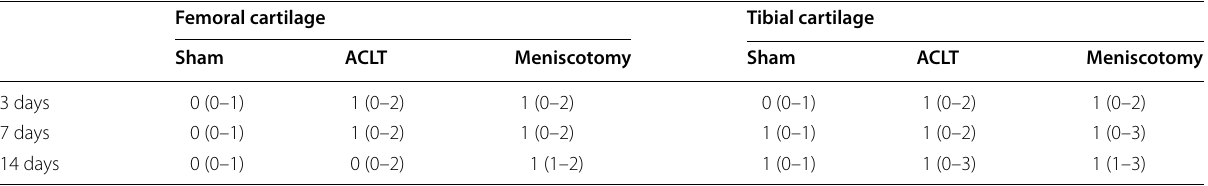
Three groups of mice were subjected to a sham procedure, transection of both the knee collateral and anterior cruciate ligaments (ACLT) or ACLT followed by transection of the medial meniscus (MNCT) and sacrificed at various days postsurgery. Structural damage of the cartlage in the distal femur and tibial plateau was evaluated using OM, according to previous criteria (see text for details). Data represent medians (range) of n using Kruskal–Wallys test